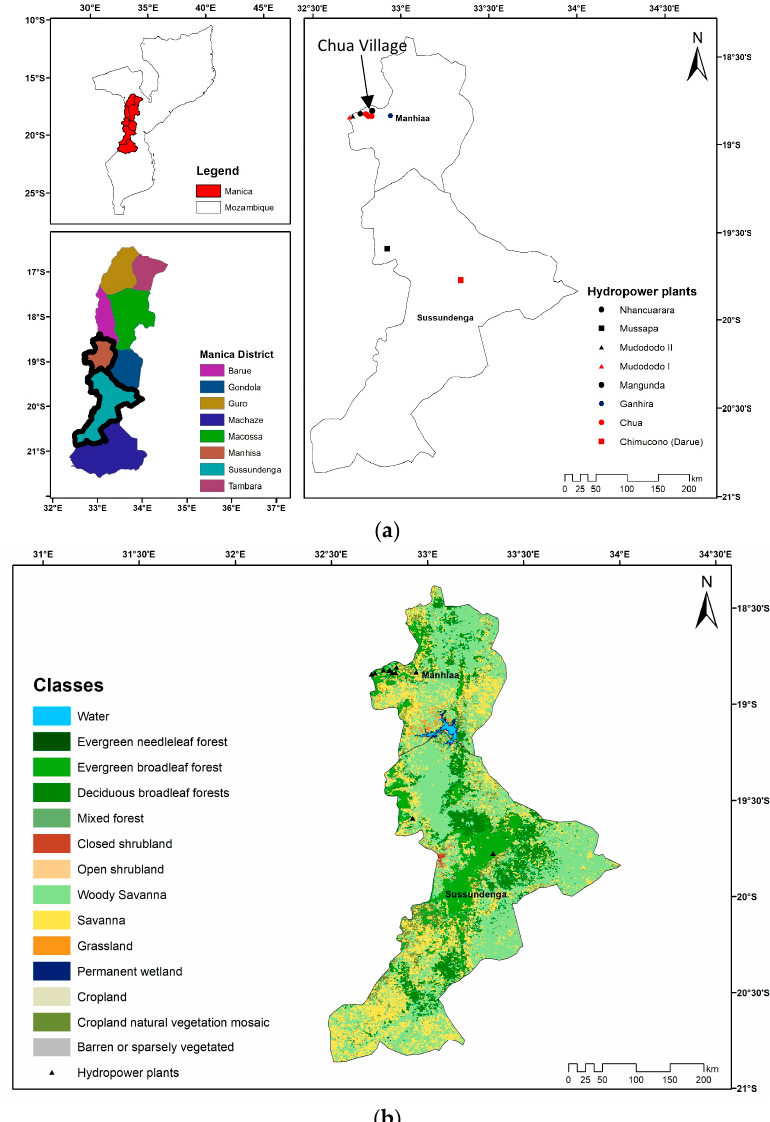
Figure 5. Chua Village location. ( a ) Manica Districts and location of major hydropower plants ( b ) Main surface use. Source: own illustration with information from